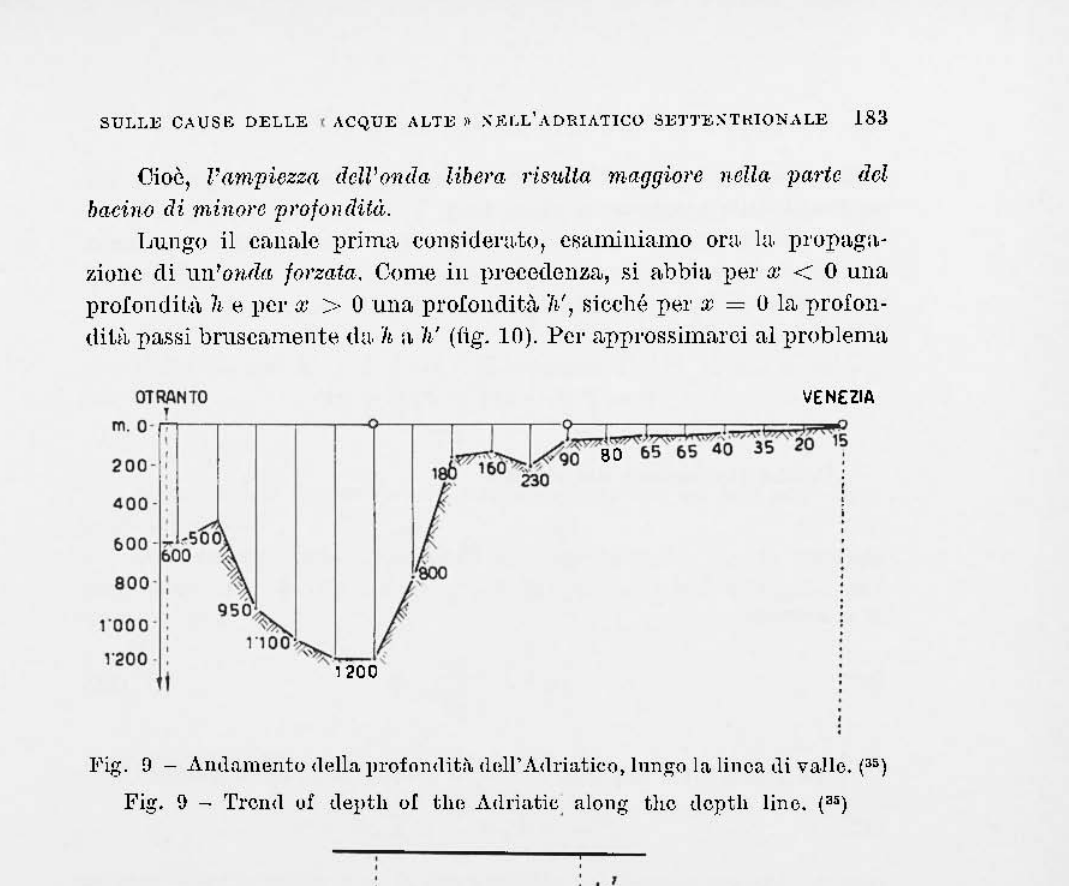
Fig. [) - TreIHI or depth or the Adriatic. along the depth lino. ("')